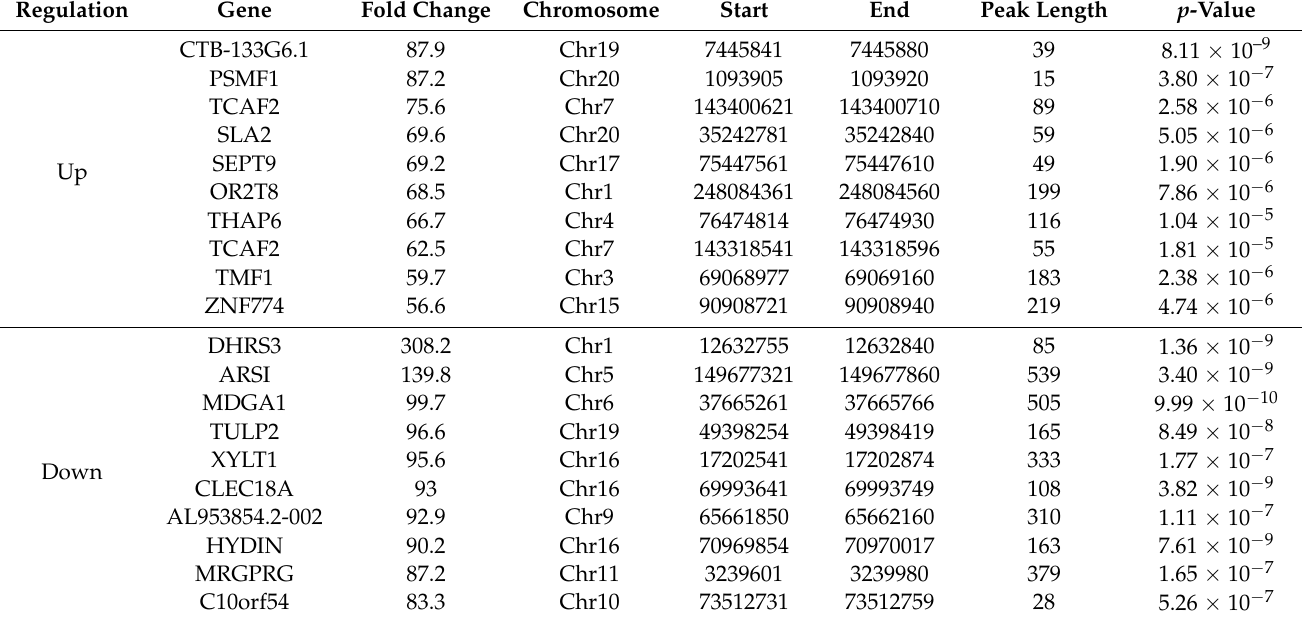
Table 2. The top 20 differentially methylated m6A